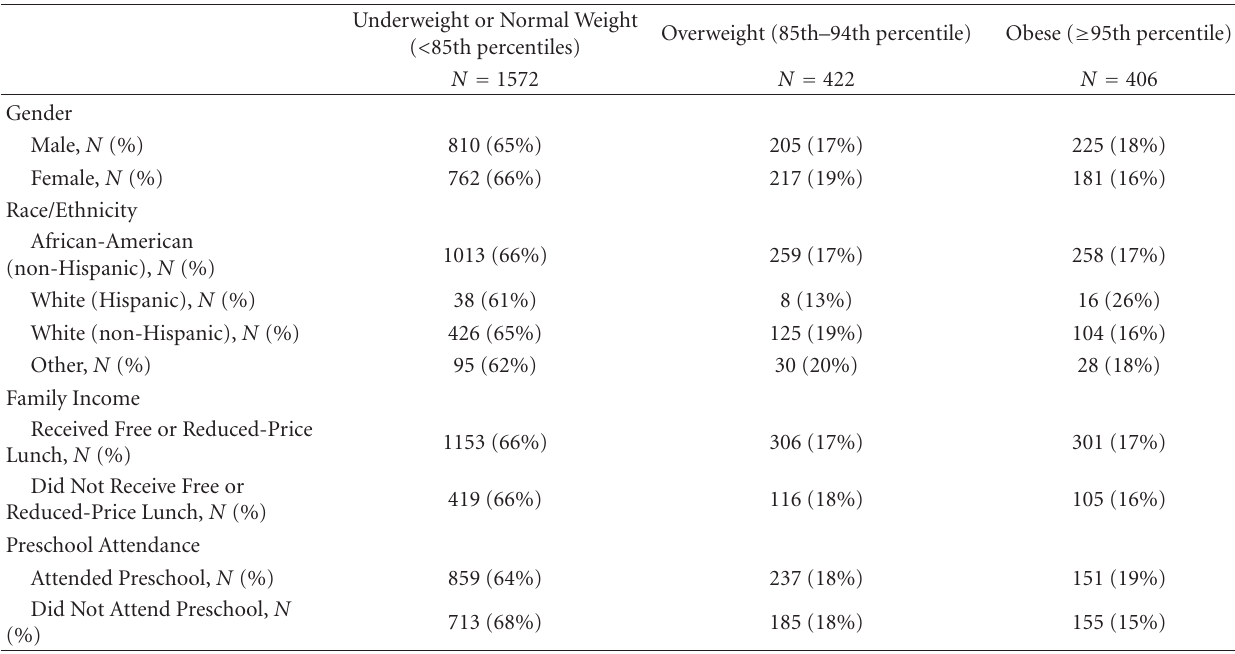
Table 1: Demographics by weight